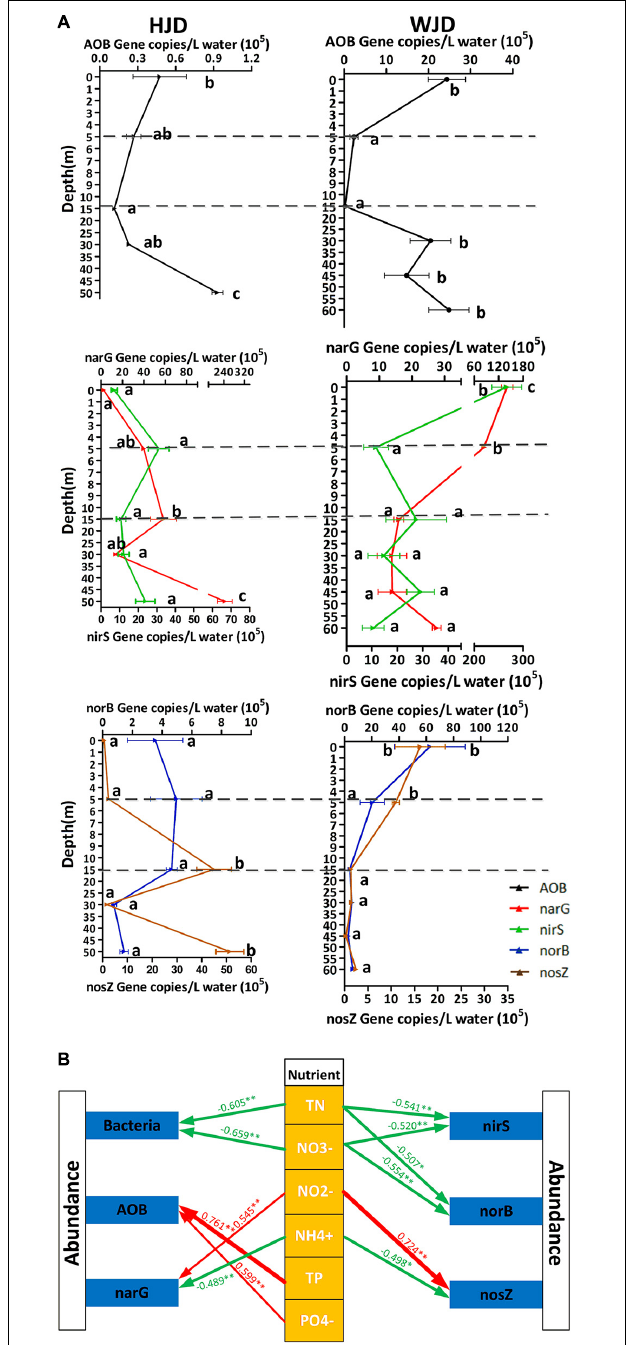
FIGURE 6 | Abundance of nitrogen functional genes and the correlation of environmental factors. (A) The absolute abundance of nitrification and denitrification genes in water stratification of the two reservoirs. Error bars represent the standard deviation ( n ≥ 4). Different letters indicate significant differences at p < 0.05 level (one-way ANOVA). (B) SPSS correlation analyses of the abundance, diversity, and environmental nutrient factors. Arrows represent positive (red) or negative (green) correlation between the variables, respectively. The arrow width is proportional to the correlation strength. Numbers on the arrows are the correlation coefficients. ∗ p < 0.05; ∗∗ p <